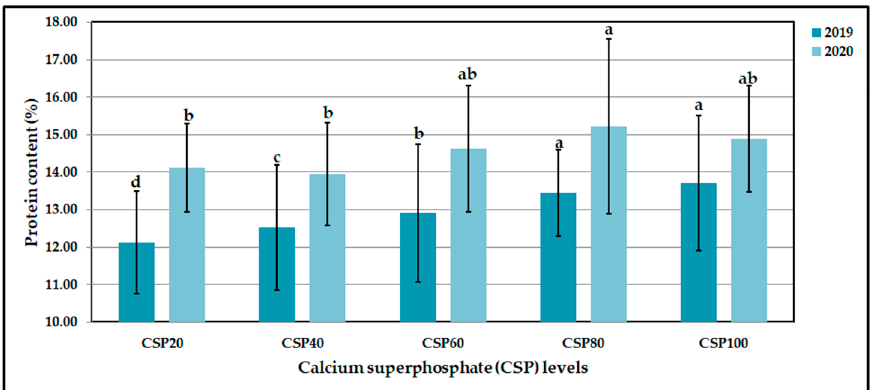
Figure 19. Influence of Bacillus megaterium DSM 2894 var. on anti ‐ radical power (ARP) of tubers of CaCO 3 ‐ stressed sweet potato plants grown in 2019 and 2020 seasons. Bars with a different letter